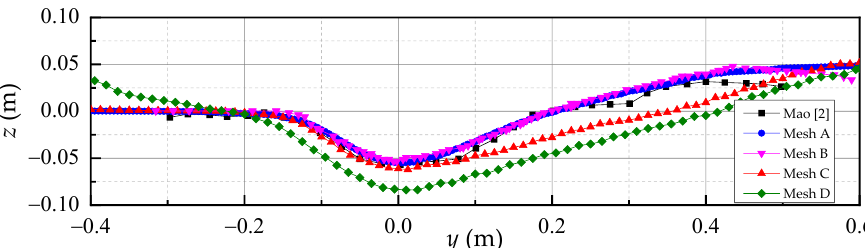
Figure 2. The numerical results of scour hole profile with different mesh levels ( t = 370 min).